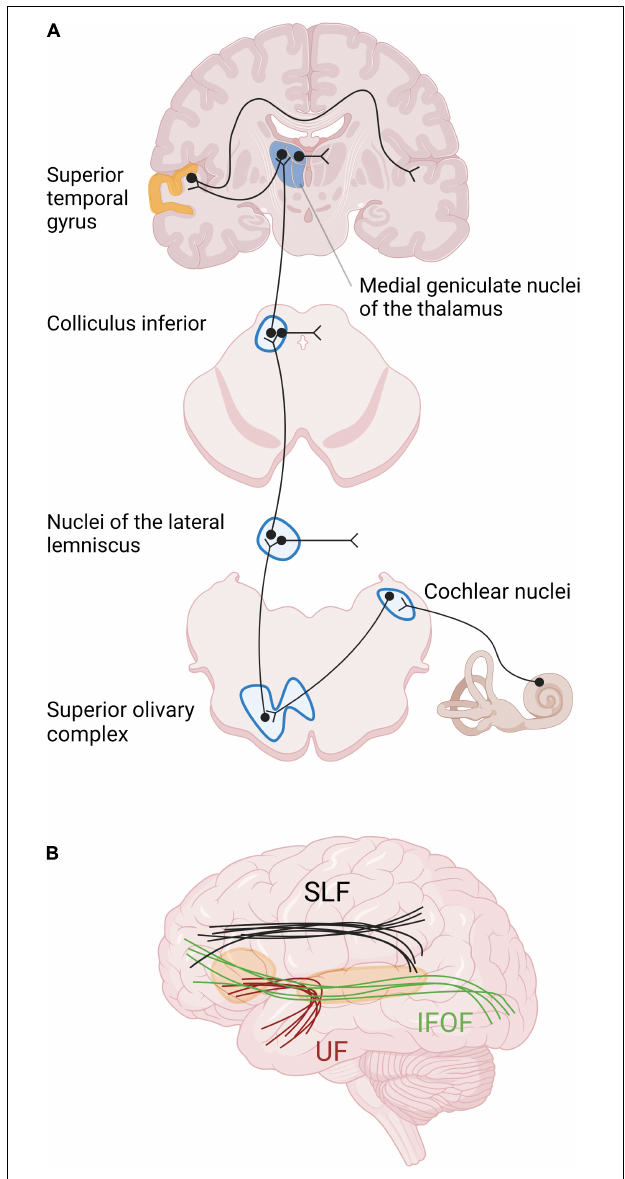
FIGURE 2 | Primary auditory pathway and main white matter tracts involved in auditory processing and language. (A) The relays of the auditory pathway are the cochlear nuclei, the superior olivary complex, the nuclei of the lateral lemniscus for some neurons, the inferior colliculus and the medial geniculate nucleus of the thalamus. The 8th cranial nerve finally reaches the auditory cortex in the superior temporal gyrus. The major part of the fibers from the cochlea cross the medial line at different levels of the neuraxis and arrive in contralateral auditory cortex. (B) The main intrahemispheric white matter bundles involved in auditory processing and language are the superior longitudinal fasciculus (SLF), the inferior fronto-occipital fasciculus (IFOF), and the uncinate fasciculus (UF), schematically represented here (Maffei et al.,